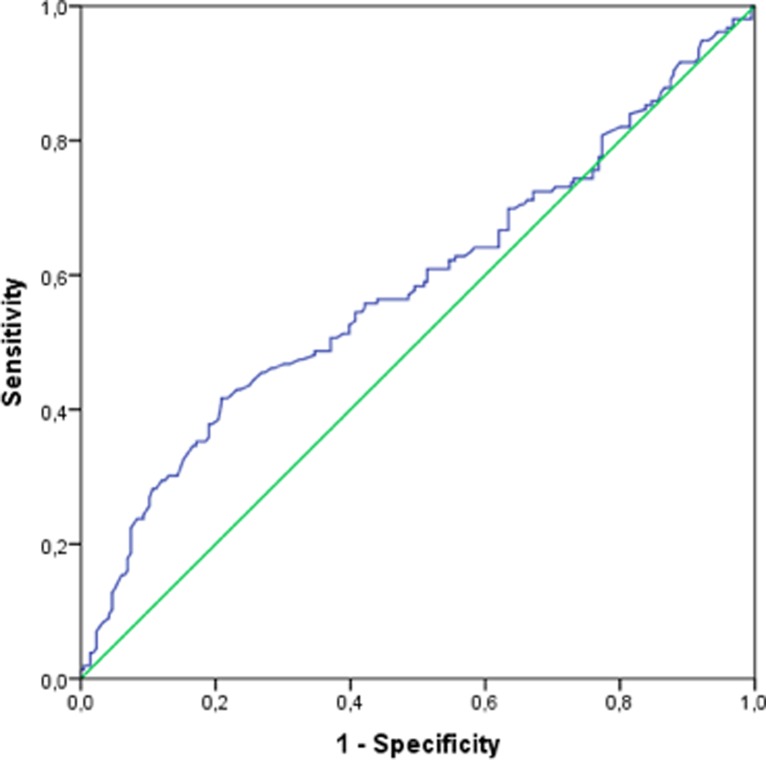
ROC curve for BW.